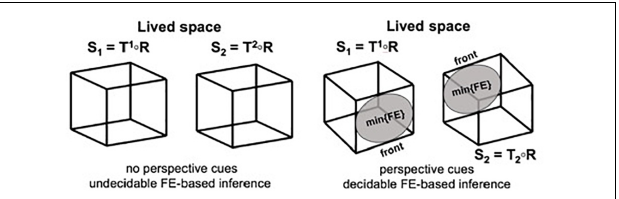
FIGURE 2 | Projective solutions to the Necker cube. Projection of two complementary views S 1 and S 2 of a generic wireframe cube R in a projective space (rendered on an image plane). (Left) When the implicit point of view is placed far away and the projective frame has a narrow scope, no perspective information remains to disambiguate the orientation of the cube. Free Energy (FE) does not possess a unique minimum, each option is unsatisfying, the inference is globally undecidable but irrepressible, and the system can oscillate between the two possible outcomes. (Right) When the implicit point of view is located near the projected cube in ambient space, perspective information helps to disambiguate the inference about the two possible orientations of the cube, T 1 and T 2 (see gray ellipses indicating the front). As a result, FE always possesses a minimum for a unique transformation T and perception can stabilize (from Rudrauf et al., 2017, used by permission from